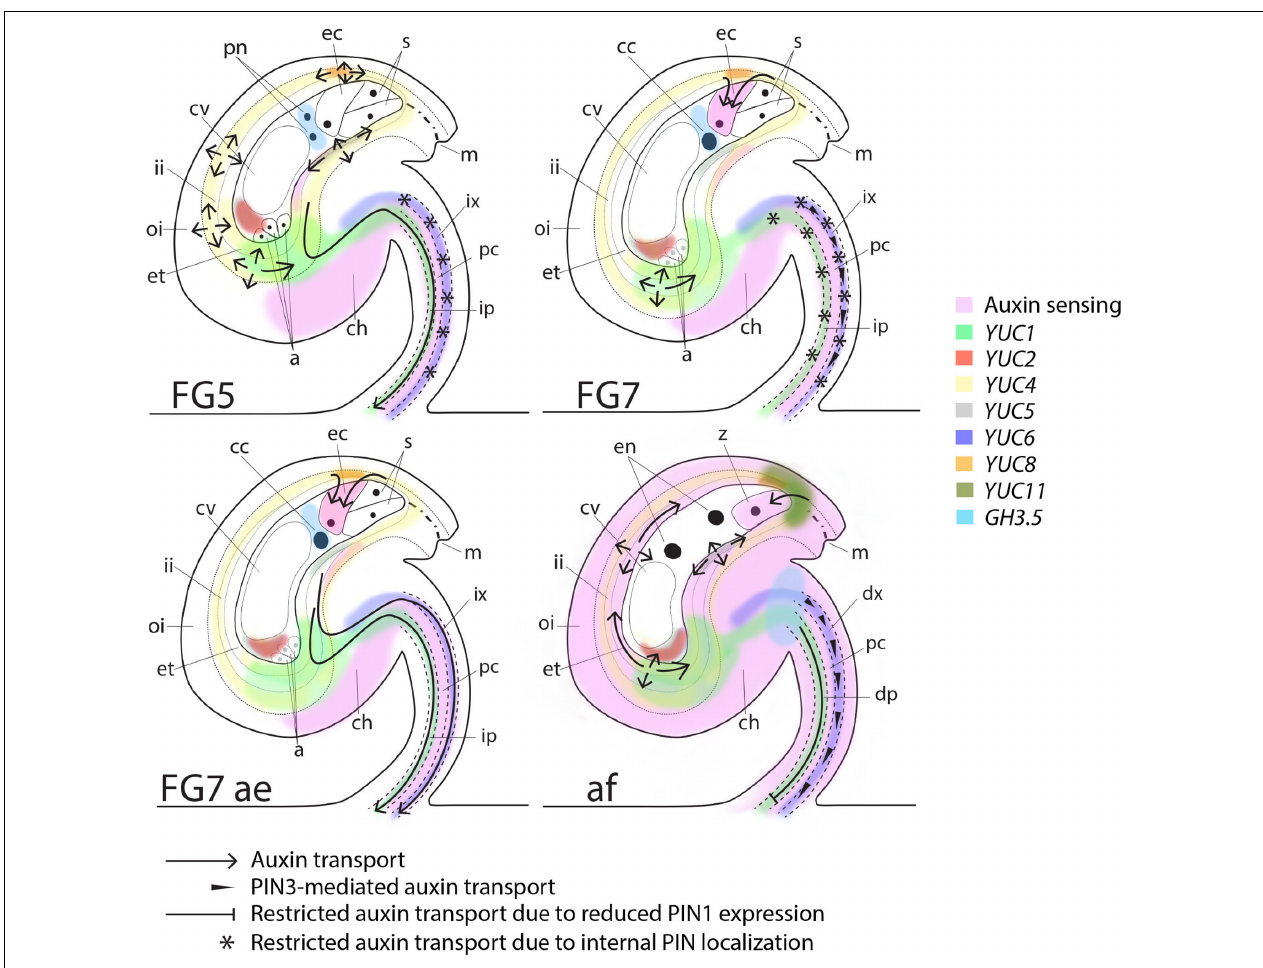
FIGURE 5 | Schematic map of auxin sensing, biosynthesis, conjugation and transport at pre-anthesis, anthesis, after emasculation and after fertilization. At the pre-anthesis stage (FG5), auxin biosynthesis, as observed by YUC expression, occurs in the inner integuments, the female gametophyte and in the funicular provasculature (pc; procambium, ip; immature phloem and ix; immature xylem). However, auxin sensing is low in the integuments and in the female gametophyte, presumably due to PGP-mediated auxin transport around the embryo sac (arrows; Lituiev et al., 2013), GH3.5-mediated auxin conjugation in the female gametophyte and PIN-mediated auxin efflux through the immature phloem of the funiculus (arrow). At this stage PIN1, PIN3 and PIN6 are all internally localized in the immature xylem (stars), presumably preventing basal auxin transport in this cell file. At anthesis (FG7), auxin sensing remains low in the integuments and the female gametophyte, but the egg cell starts sensing auxin, which presumably is delivered by AUX1 (Panoli et al., 2015) from the surrounding tissues (arrows). Auxin transport through the immature phloem in the funiculus is repressed by internalization of PIN1 (stars), while basal transport is slightly induced in the immature xylem by increased polarization of PIN3 (arrowheads). If the flowers are emasculated before anthesis (FG7 ae), polar auxin transport through the funicular provasculature is stimulated by basal polarization of PIN1 and PIN6 (arrows), while auxin biosynthesis and auxin sensing in ovules remain unchanged compare to in ovules of non-emasculated flowers. Shortly after fertilization (af), auxin sensing increases drastically throughout the sporophytic tissues of the ovule. Auxin biosynthesis increases in the micropylar end of the integuments through YUC5 and YUC11 activation, while GH3.5-mediated auxin conjugation decreases in the endosperm and increases in the apical part of the funiculus. Auxin transport in the differentiating phloem (dp) in the funiculus is restricted through reduced PIN1 expression levels (blocked arrow) and in the differentiating xylem (dx) through reduced PIN1 and PIN6 expression levels. PIN3, however, remains expressed and basally localized in the dx, presumably retaining a certain level of auxin transport in this cell file (arrowheads). In addition, PIN3-mediated auxin transport is induced in the integuments (arrows), presumably to facilitate the spreading of auxin throughout the sporophytic tissues. PIN3 is also expressed and basally localized in cell file 4 of the funiculus throughout all analyzed stages. This suggests that PIN3-mediated auxin transport in the cell file between the differentiating phloem and the differentiating xylem is not important for the changes in ovule development from before anthesis to after fertilization and is therefore not indicated in the